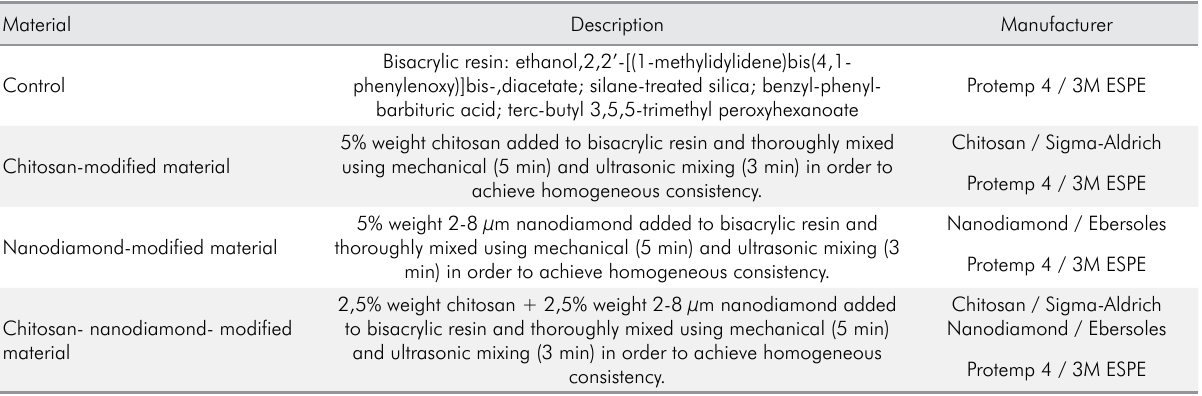
Table 1. Materials used.